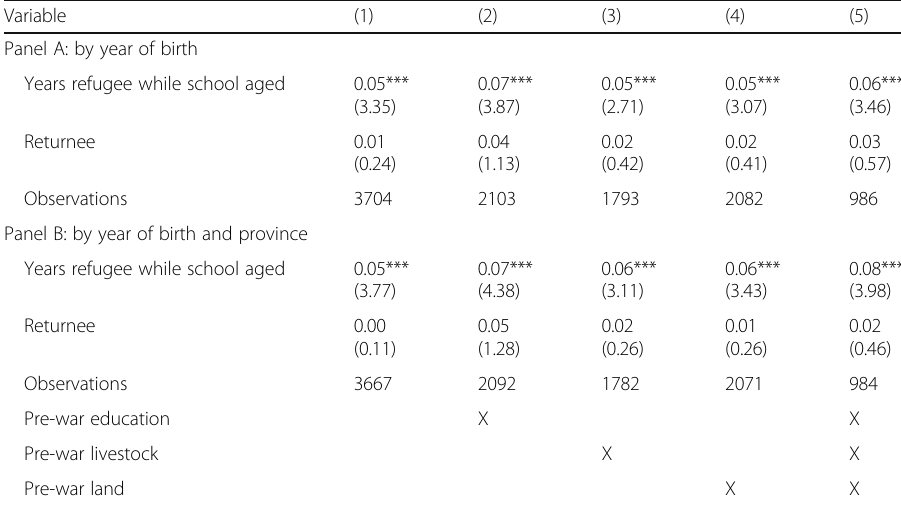
Table 7 Impact of years abroad during school age on the likelihood of finishing primary school controlling for years of exposure to conflict while school